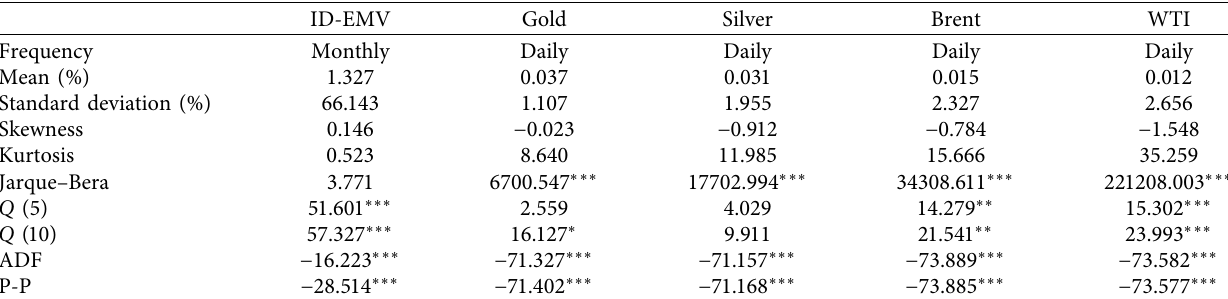
Figure 1: Time evolutions of returns for precious metal and crude oil futures. Table 1: Descriptive statistics for ID-EMV and commodity futures